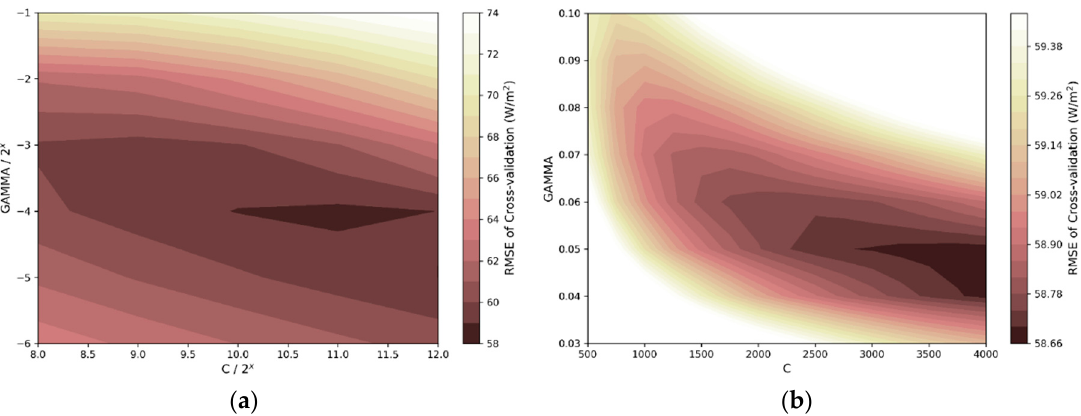
Figure 8. Cross-validation RMSE of the Support Vector Regression (SVR) method with various hyperparameter combinations. ( a ) A wide range; ( b ) a narrow range.